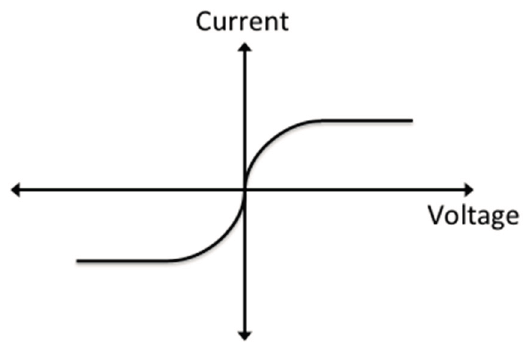
Figure 1. I-V curve of n-p-n